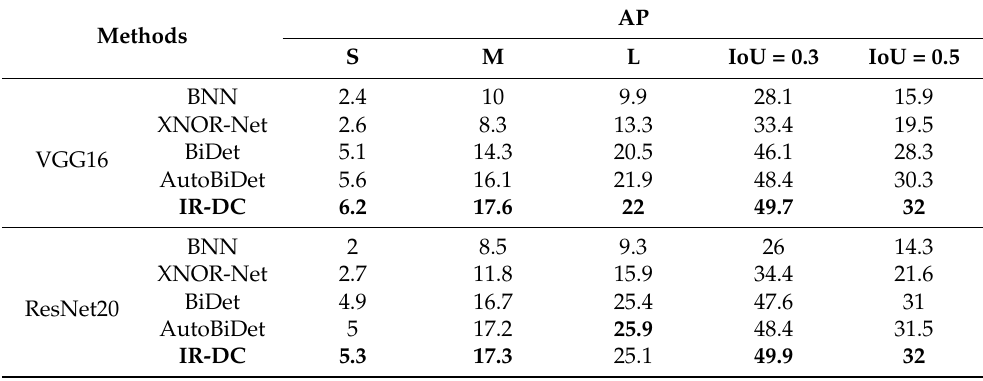
Table 9. Results of